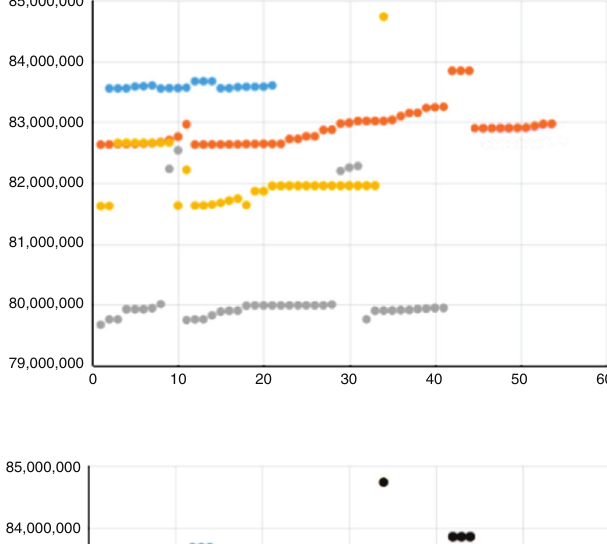
Figure 16. Actual clusters of “ MOOCs ” data set